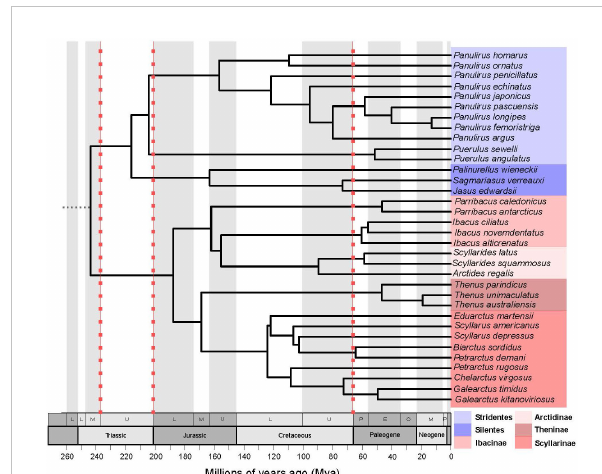
FIGURE 3 Time-calibrated maximum clade credibility tree of Achelata species used in phylogenetic comparative analyses (34 species). Blue-scaled coloured tips designate Palinuridae species, while red-scaled designate Scyllaridae species. Red-dotted lines indicate massive extinction